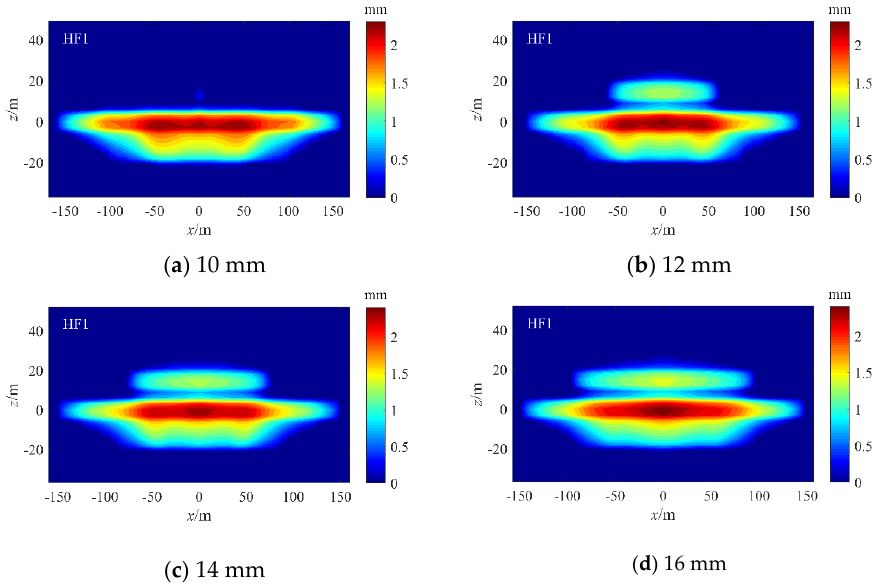
Figure 9. Patterns of the heel − end fractures (HF1) at different perforation diameters.